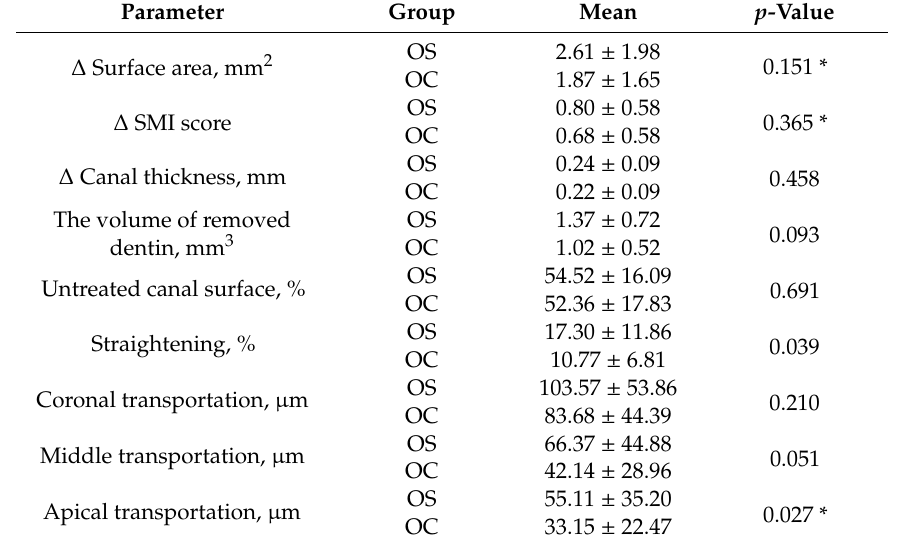
Table 1. Mean ± standard deviation of the absolute values and percentages of post-instrumentation changes in surface area; structure model index (SMI) score; canal thickness; volume of removed dentin; untreated canal surface; canal transportation in the coronal, middle, and apical thirds; and straightening of the